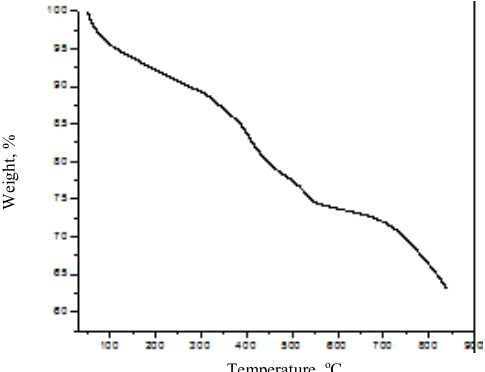
Figure 3. TGA curves of DSBA doped tetraaniline under N per